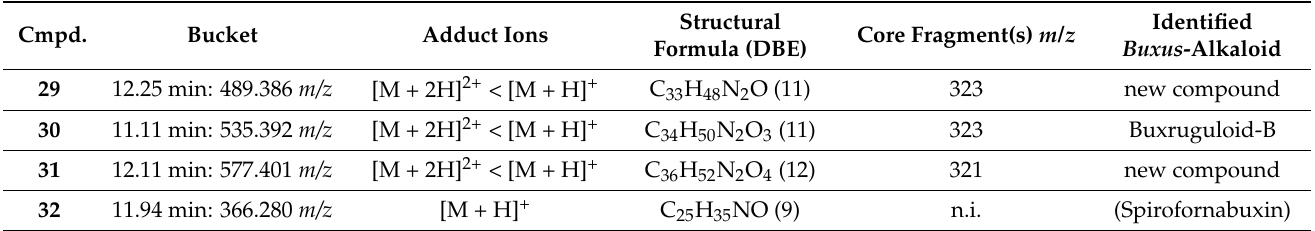
Table 3. LC/MS-characteristics of unique features (compare Figure